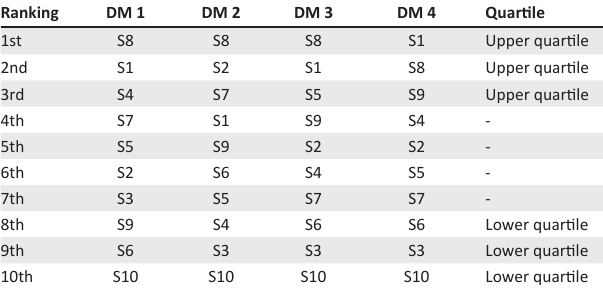
TABLE 9: Applying the voting procedure to supplier